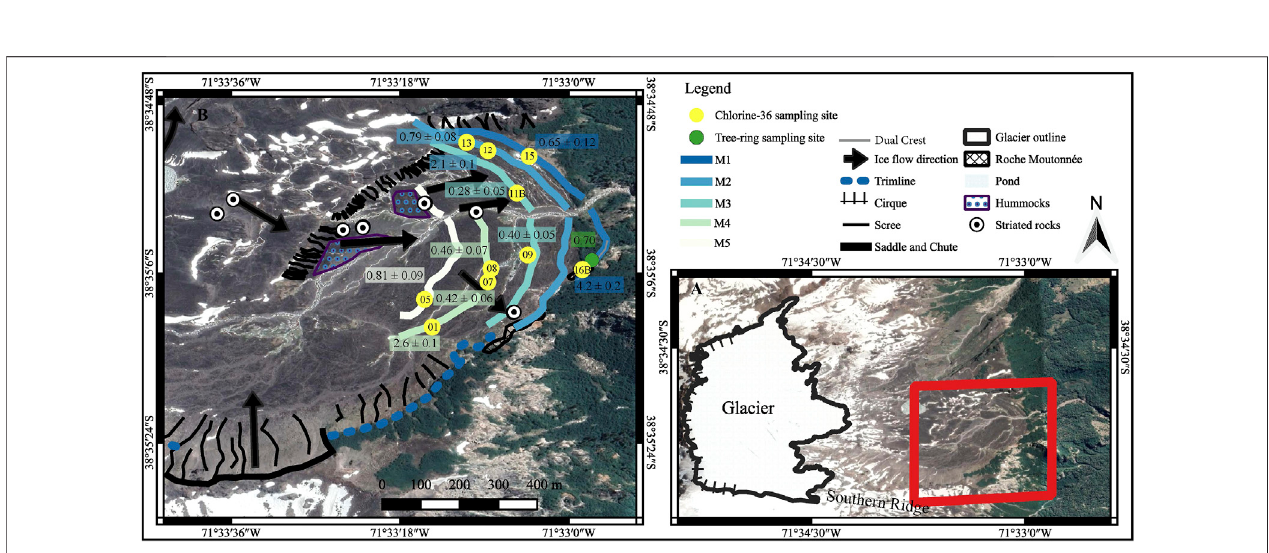
FIGURE 3 | Panel (A) Google Earth image of the Monte Sierra Nevada fi eld site, with the modern glacier outlined in black and the moraine complex outlined in red. Panel (B) Arielphotograph ofthe fi eldsite asdelineatedbyred boxinpanel A.Map identi fi esglacial moraines (M1-M5), locations ofsamplestakenfor 36 Cl (yellowcircles with abbreviated sample number) and tree ring (green circle) dating. 36 Cl ages are reported in thousand years before present with internal uncertainty. Probable ice fl ow directions are represented by black arrows based on observed striated rock surfaces (white circles). Trimline along the southern ridge of the valley is marked (blue dashed line), as well as the saddle and chute (black